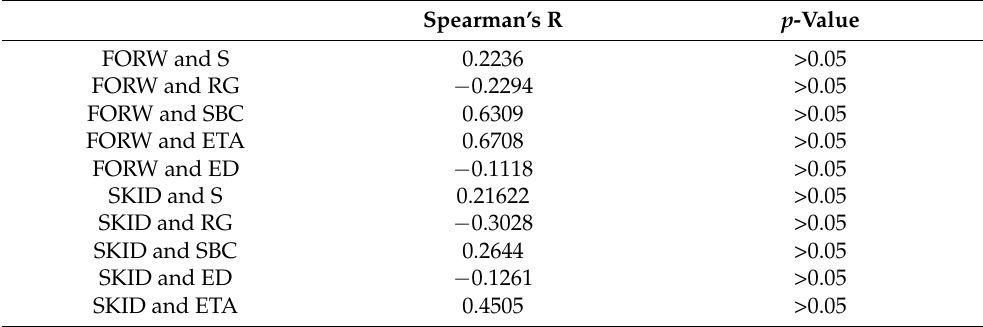
Table 5. Spearman’s R and p -value for the various couple comparison between variations of suitability values for forwarder and cable skidder and variations of the six variables’ values. For variation, what is meant is the difference between the values calculated from FMP data and the values retrieved after the field surveys carried out in the present study. FORW: forwarder; SKID: skidder; S: slope; ED: extraction distance; SBC: soil-bearing capacity; ETA: extracted timber amount; RG: terrain roughness. Spearman’s R p -Value FORW and S 0.2236 >0.05 FORW and RG −